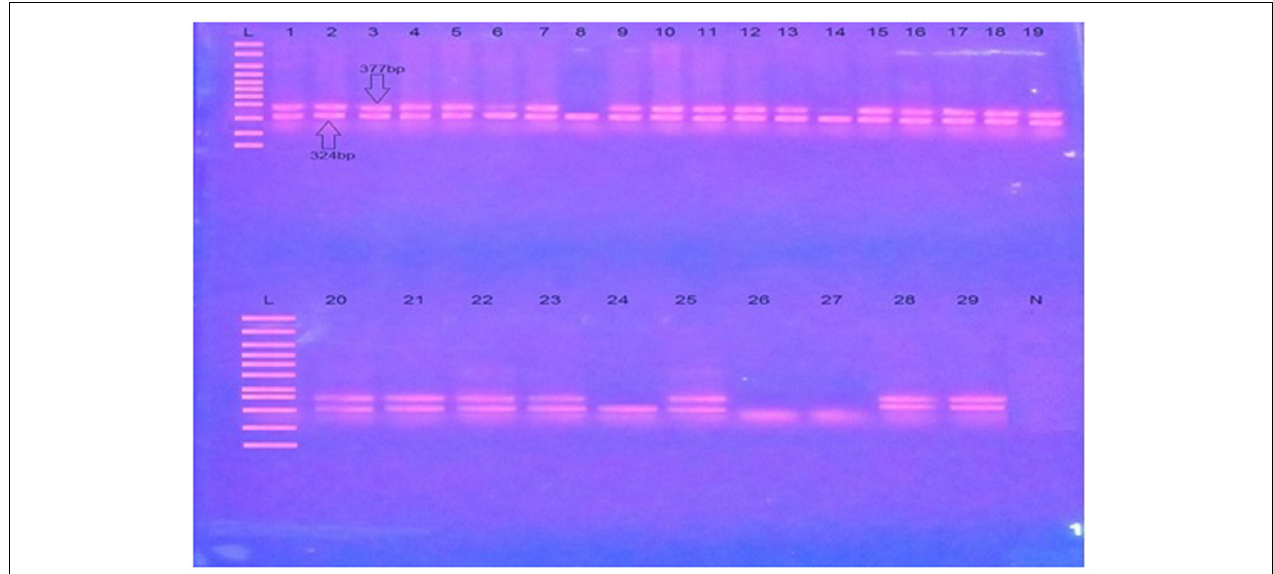
FIGURE 2 | A representative image of PCR analysis of Tg APP. L is molecular weight marker (100 bp). N is negative control. 1–29 are test samples. Transgenic samples are shown by the presence of double bands one of transgene (377 bp) while other of internal positive control (324 bp), while non transgenic samples lack transgene (377